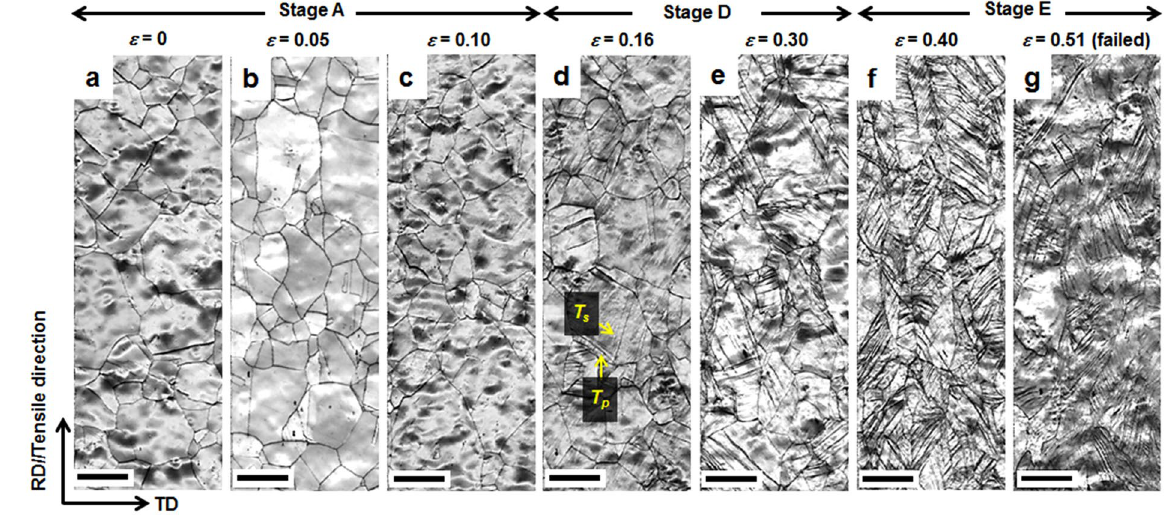
Figure 3. EBSD image quality maps showing microstructural evolution with true strain in 3C steel. The strains are ( a ) 0, ( b ) 0.05, ( c ) 0.10, ( d ) 0.16, ( e ) 0.30, ( f ) 0.40 and ( g ) 0.51 (failed specimen). RD and TD: rolling and transverse directions, respectively. T p and T s : primary and secondary mechanical twins, respectively. Scale bar, 10 μ m.